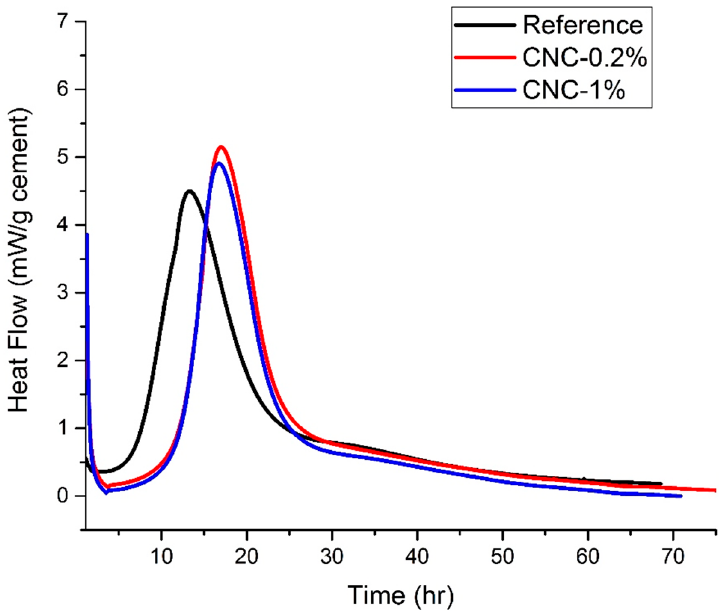
Figure 8. The heat flow of all samples versus time.